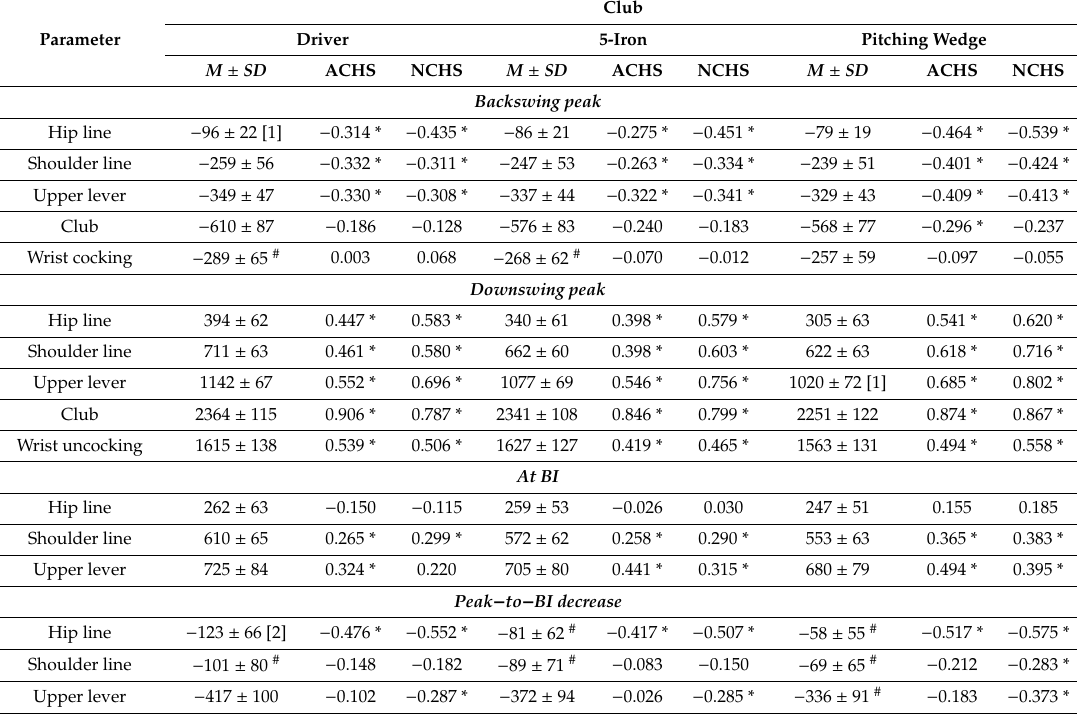
Table 4. Correlation coe ffi cients of the angular velocity parameters (in ◦ / s) to clubhead speed ( n = 66).